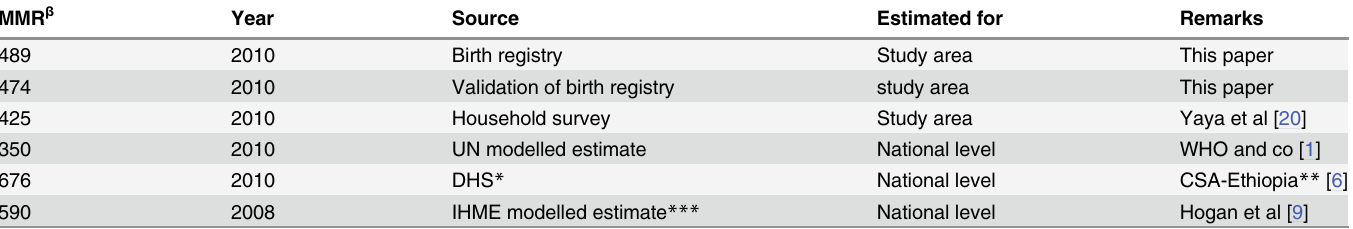
Table 5. Estimates of the maternal mortality ratio per 100,000 live births in the study area compared with national estimates in Ethiopia during the years around